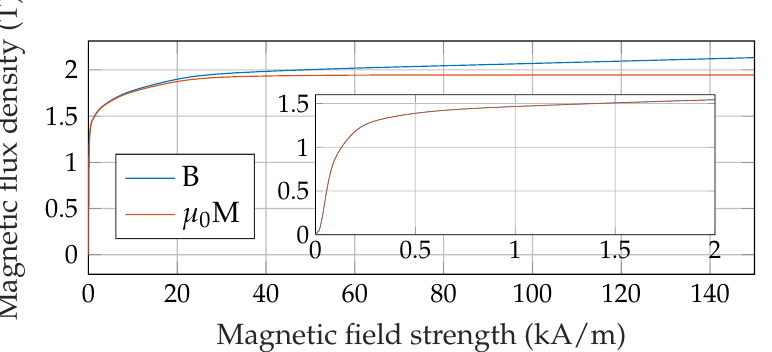
Figure 2. The BH-curve for the soft magnetic material, Silicon Steel NGO 50PN270 used in the simulations. As can be seen in the zoomed-in version, the hysteresis is not considered in the study.